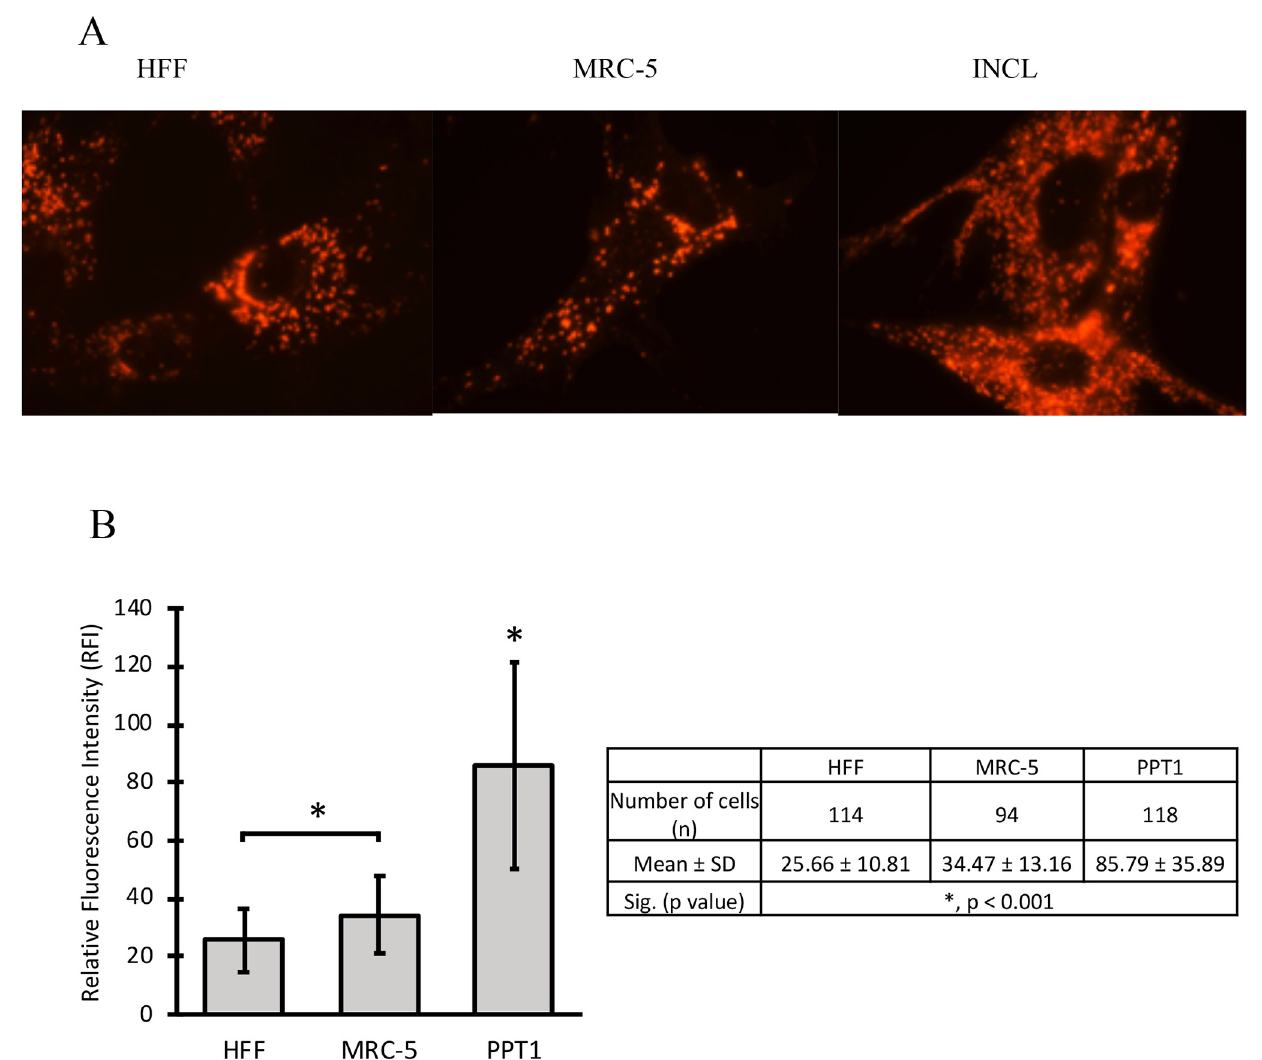
Fig 4. The cytosol of PPT1-deficient fibroblasts is densely packed with lysosomes. (A) HFF, MRC-5 and PPT1 patient cells stained with LAMP1 antibody show the distribution of lysosomes. The density of LAMP1 signal increased in INCL cells as compared to controls. (B) The average LAMP1 signal intensity for the total area occupied by lysosomes was measured using ImageJ (n = 94–118 cells per group). Significant differences were found between controls ( � , p < 0.001). PPT1 patient cells had significantly higher signal compared to both controls ( � , p < 0.001). Error bars display